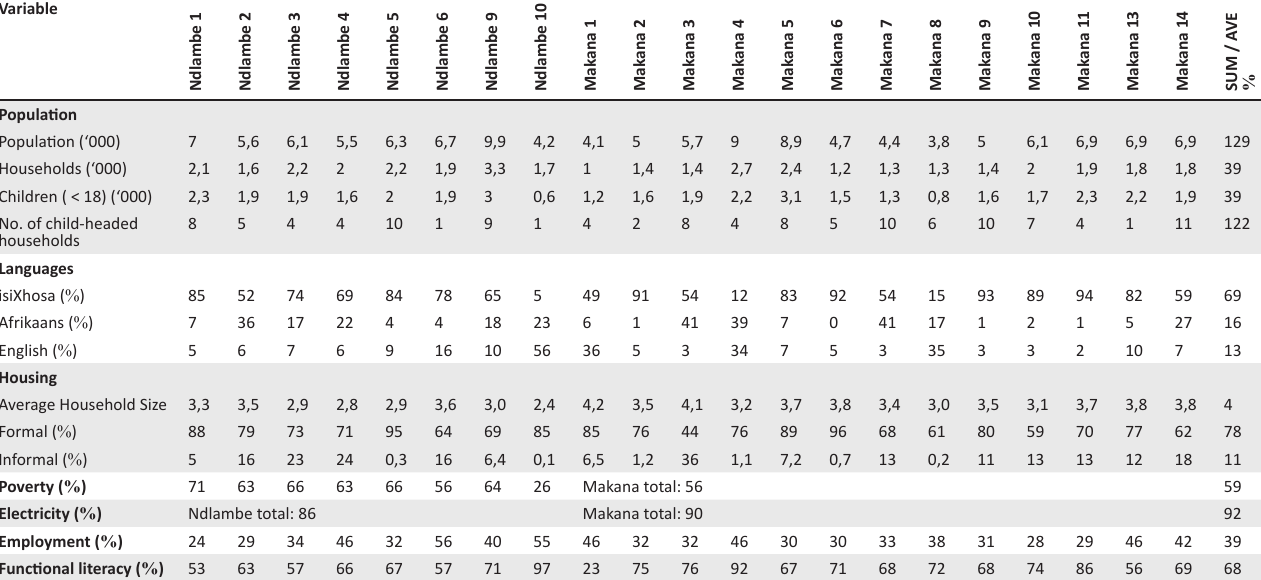
TABLE 1: Demographics of the target communities.